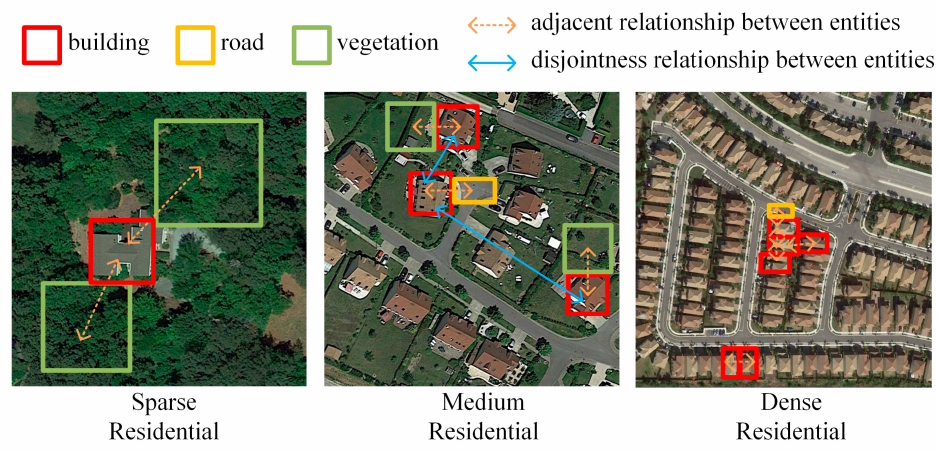
Figure 1. Illustration of spatial and topological dependency among entities in RS scene